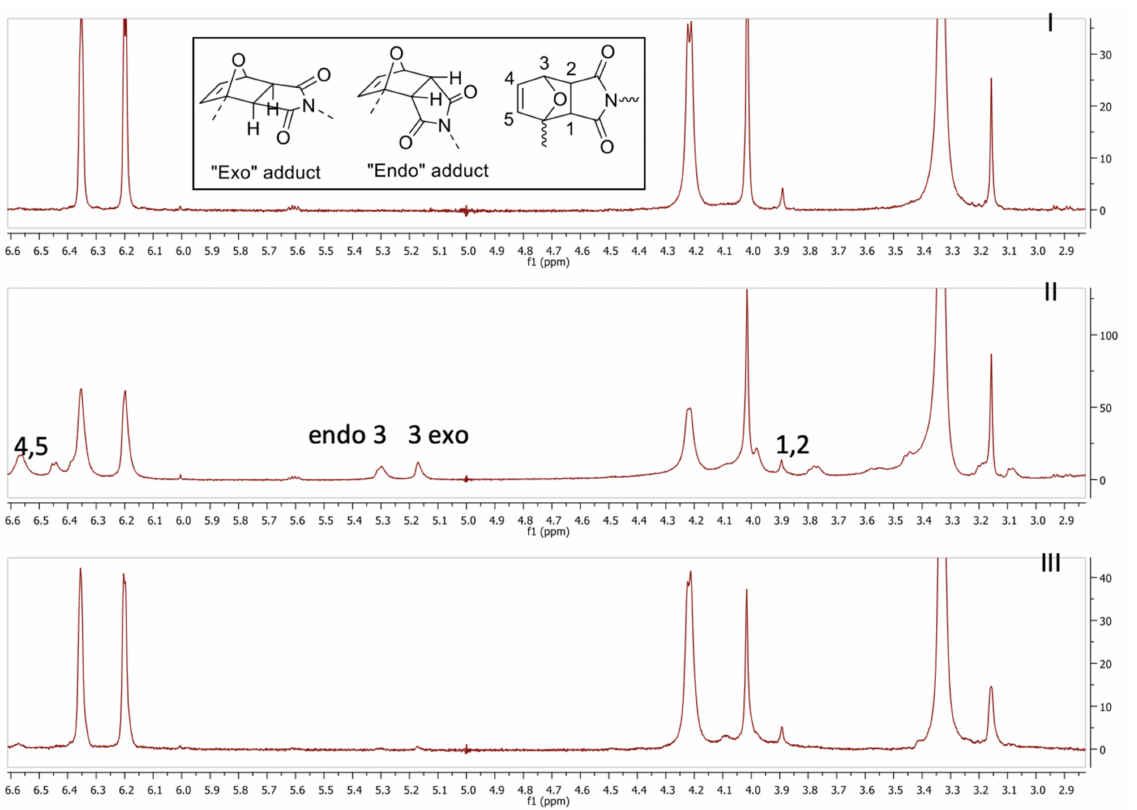
Figure 2. NMR spectra of uncrosslinked polymers and bismaleimide; ( I ): no reaction, ( II ): 3 h at 50 ◦ C, ( III ): 5 min at 150 ◦ C. Inset: both regioisomers and